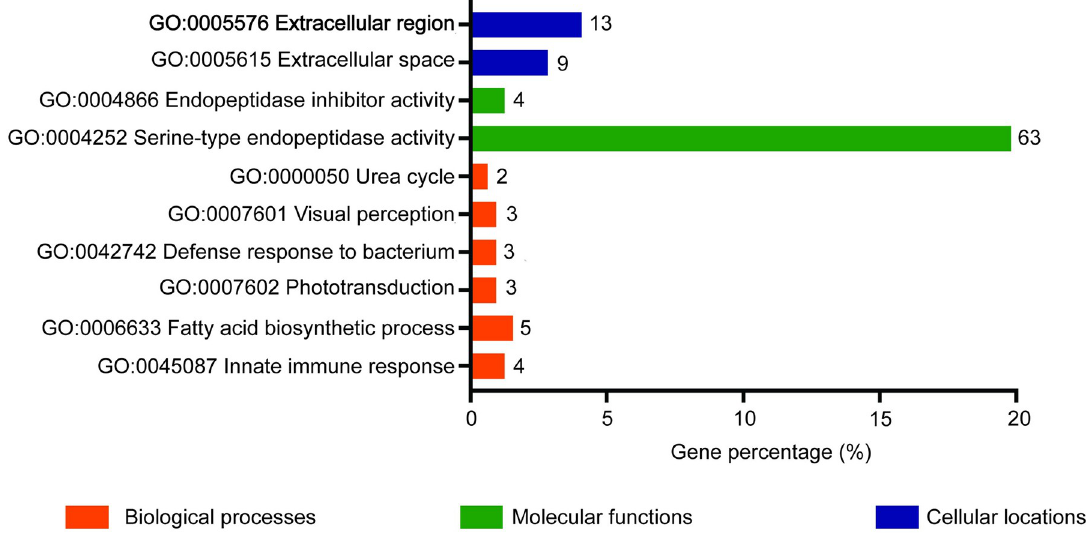
Fig 7. Gene ontology analysis of upregulated differentially expressed genes common to all Wolbachia -infected Aedes aegypti versus uninfected mosquitoes. The number next to each bar refers to the number of genes involved in the biological process, molecular function or cellular